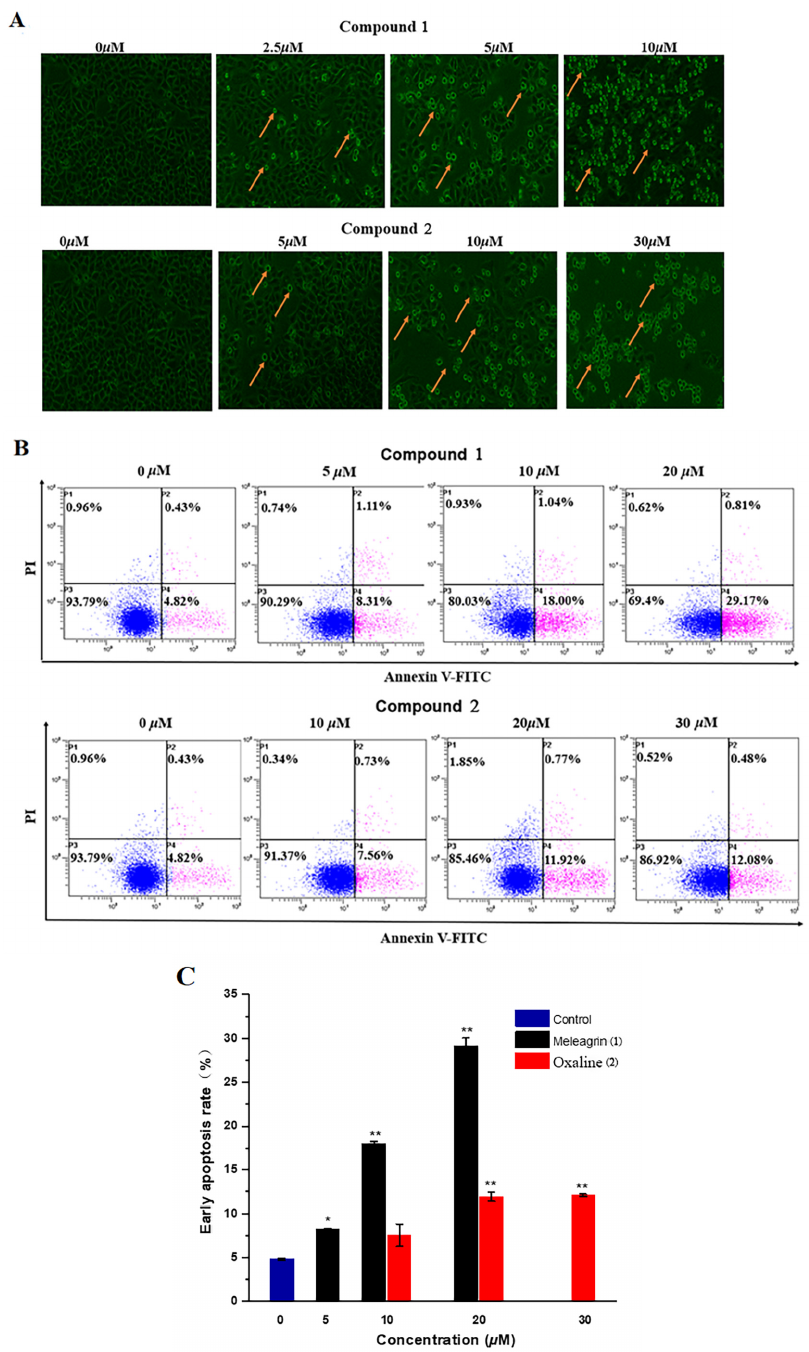
Figure 5. Meleagrin ( 1 ) and oxaline ( 2 ) induced an apoptosis rate in HepG2 cells. ( A ) Morphological changes in HepG2 cells were observed with microscopy (400 × magnification). ( B ) On the flow cytometry is a two-parameter scatter plot: the lower left quadrant shows live cells (LL: Annexin V-/PI-); the lower right quadrant is the early apoptotic cell (LR: Annexin V /PI-); the upper right quadrant is the late apoptotic cell (UR: Annexin V /PI); and the upper left quadrant is a non-live cell and necrotic cell (UL: Annexin V-/PI). ( C ) The quantification of early cell apoptosis. Data are the means ± SD of three independent experiments. * p < 0.05, ** p < 0.01 vs. control group. According to the results of the bioactivity evaluation, meleagrin ( 1 ) showed a wide range of cell proliferation inhibition, and oxaline ( 2 ) exhibited good cytotoxicity that was selective against the HepG2 cell. It can be concluded that meleagrin and oxaline can effec- tively inhibit the proliferation and migration of human HepG2 cells, and oxaline signifi- cantly inhibits the healing of cancer cell HepG2 scratches at a concentration of 1 μ M. More- over, two compounds were able to induce G2/M phase cell cycle arrest and the apoptosis of HepG2 cells in a certain concentration-dependent manner. In view of the good biolog- ical activity of compound 1 , we decided to increase its yield through fermentation optimi- zation.